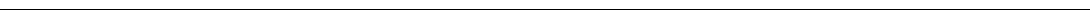
blots. Primary antibodies used: β -actin (1:5000, Cat. No. 3700), Akt (1:1000, Cat. No. 9272), phospho-Akt (1:1000, Cat. No. 4051), Erk (1:1000, Cat. No. 4695), phospho-